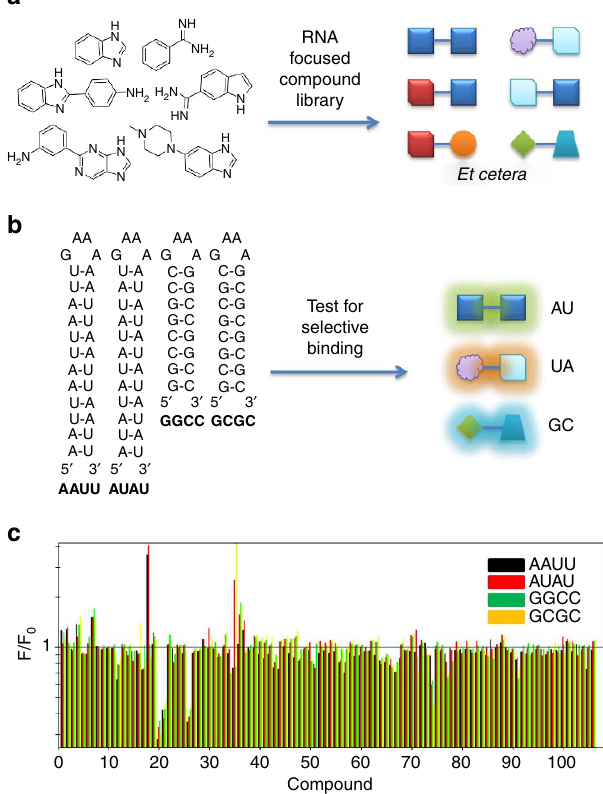
Figure 1 | Overall scheme to identify small molecules that bind to RNA base pairs. ( a ) A small molecule library was collected in which the small molecules have chemotypes present in compounds known to bind RNA. ( b ) The RNA-focused small molecule library was tested for binding to four different RNAs that have different orientations and identities of RNA base pairs. ( c ) Compounds were tested in a fluorescence emission assay for selectively binding to RNAs with different paired elements. Compounds that were selective were further